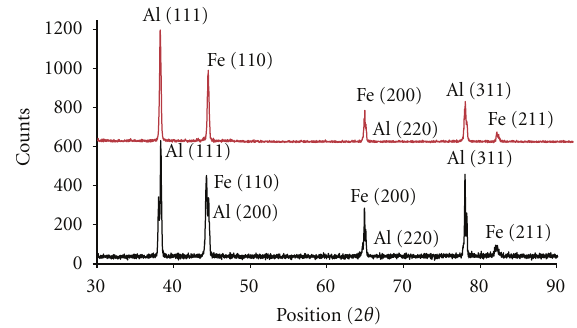
Figure 5: XRD plots of two samples, namely, T5 (top) and T6